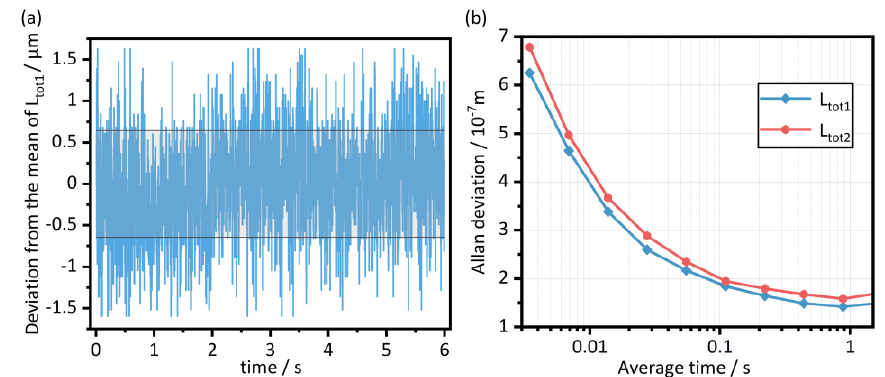
Figure 5. Results of the equivalent absorption path length measurement. ( a ) Measurement data of L tot1 separated at an interval of 5 min. Each set of data had a length of 1 s. The gray area represents the ± σ interval (calculated from 6 s data, σ = 0.6 μm). ( b ) Allan deviation of the path lengths measurement.